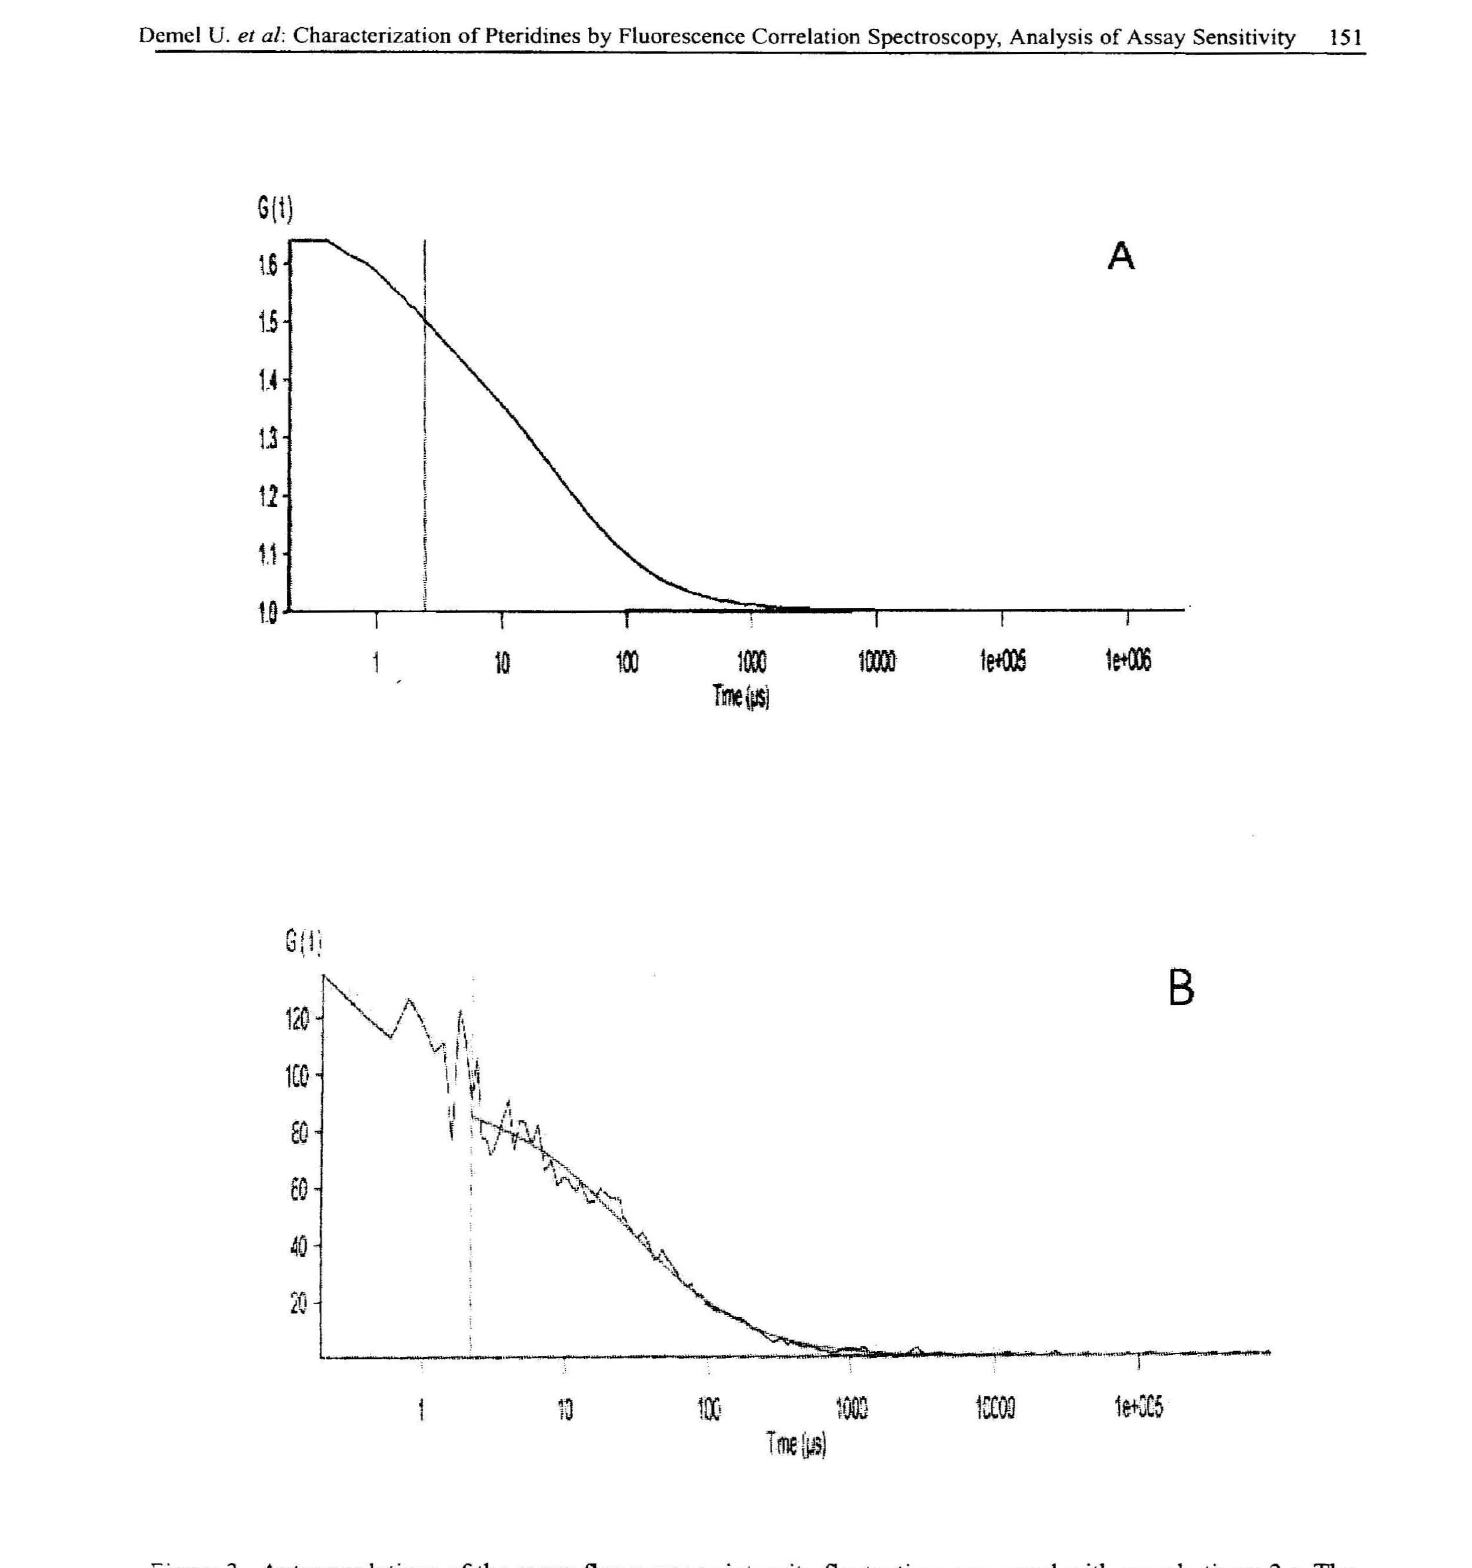
Figure 3. Autocorrelations of the green fluorescence intensity fluctuations measured with sample times 2 s. The measured curves are depicted in black. The red curves represent the autocorrelation functions of Eqn.l . We only consider the physical process of three-dimensional diffusion of the fluorophore rhodmaine green through the vol ume element of detection. A: Bulk solution of 20.116 nM rhodmaine green. B: Bulk solution of 0.109 nM rhod maine